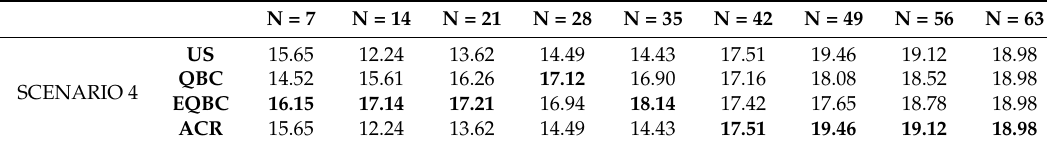
Table 6. LEI (SVM) in Scenario 4 (%).